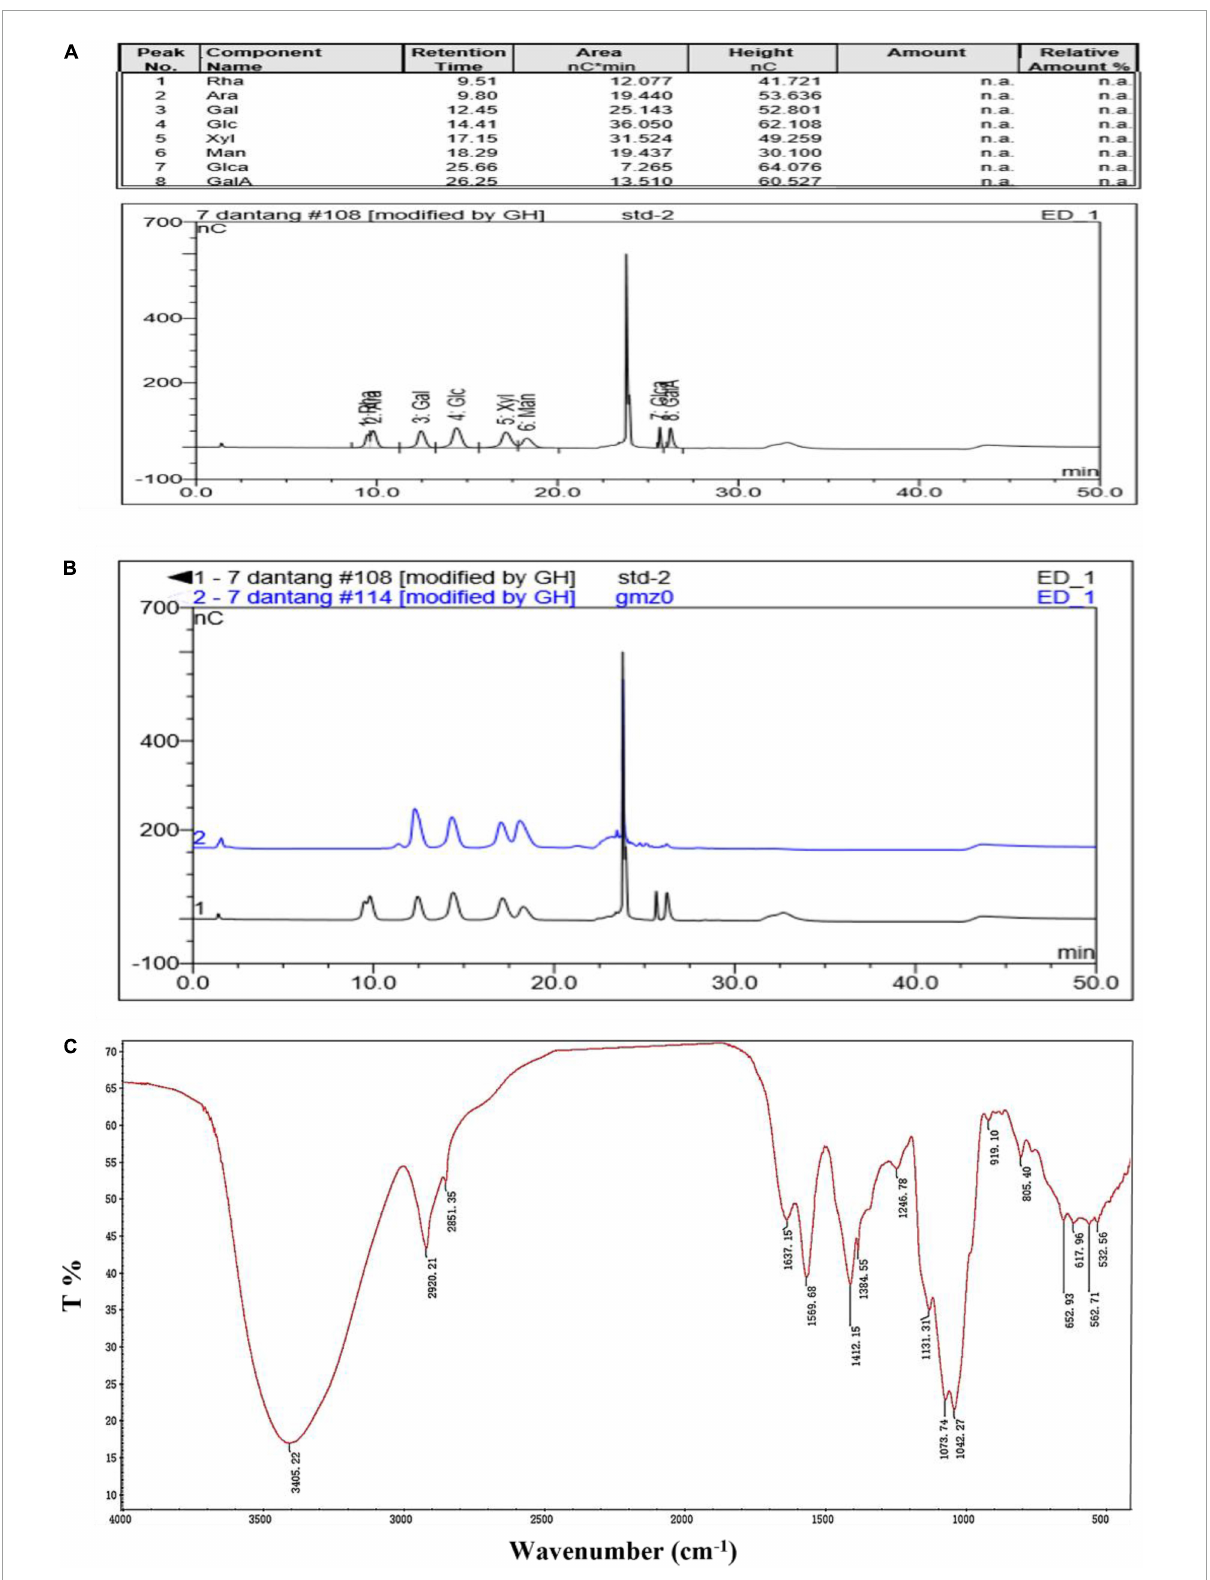
FIGURE2 Monosaccharide composition [ (A) Standards, (B) CCP2 (Blue line)] and the FTIR spectrum (C) of